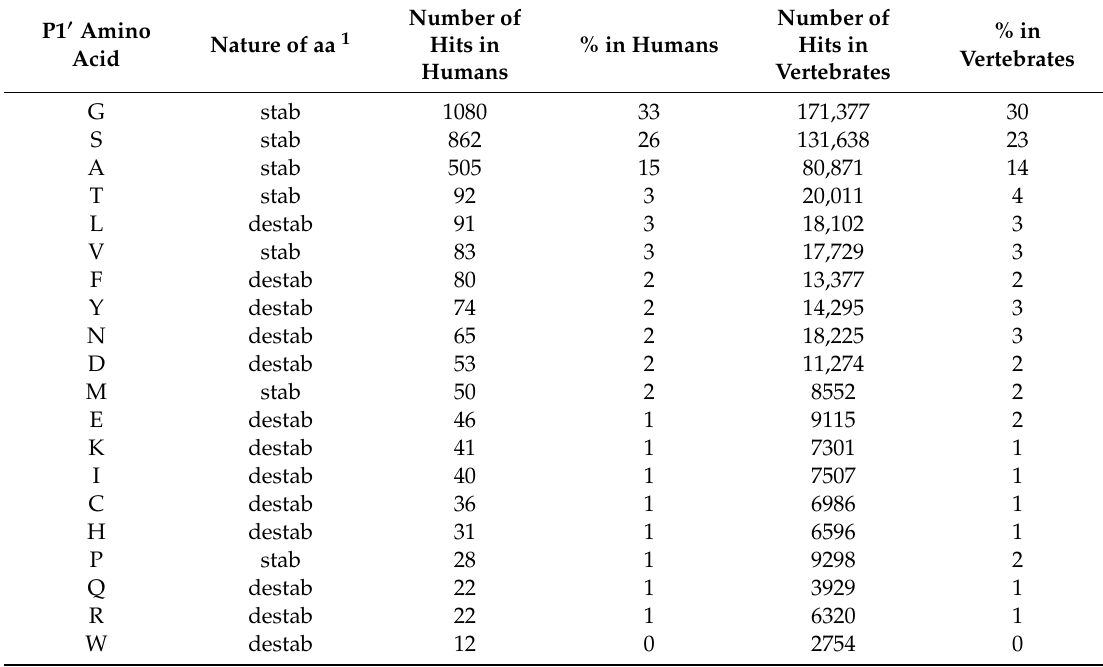
1 stab: stabilizing after caspase cleavage, destab: destabilizing e ff ect, according to the Arg / N-degron